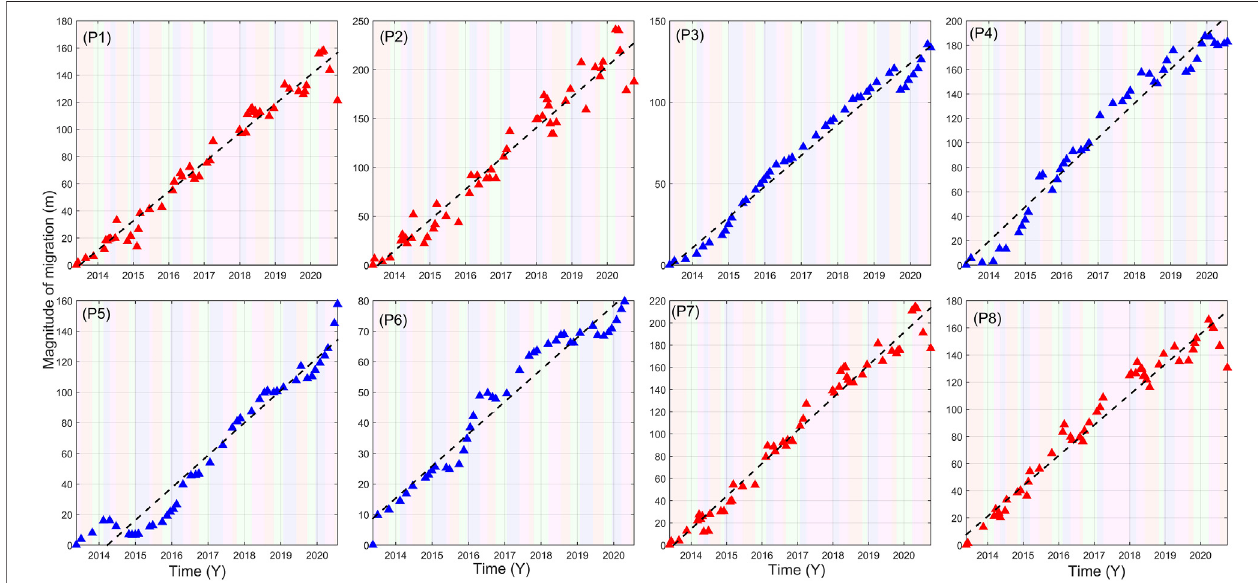
FIGURE 6 | Cumulative projected displacements over time extracted from the inversion of the deformation maps belong to two Landsat-8 frames. The dashed colored areas in the background represent the different seasons: red, blue, green, and magenta refer to summer, winter, autumn, and spring, respectively. The black dashedlinesdenotethebestlinear fi tofthecumulativeprojecteddisplacement.Redandbluetrianglesdenotethepointsbelongingtothecoverageof(183/48)and(184/ 48), respectively.